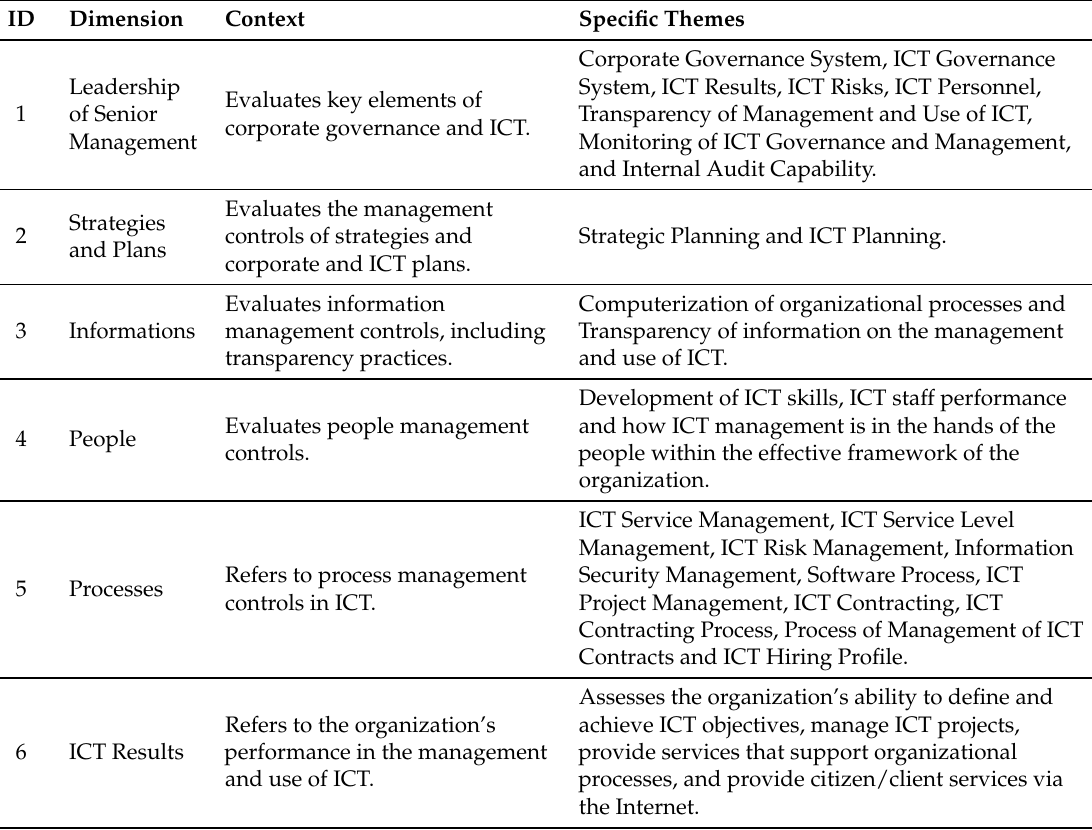
Table 1. Specific Dimensions and Themes Proposed by TCU to Calculate iGovIT